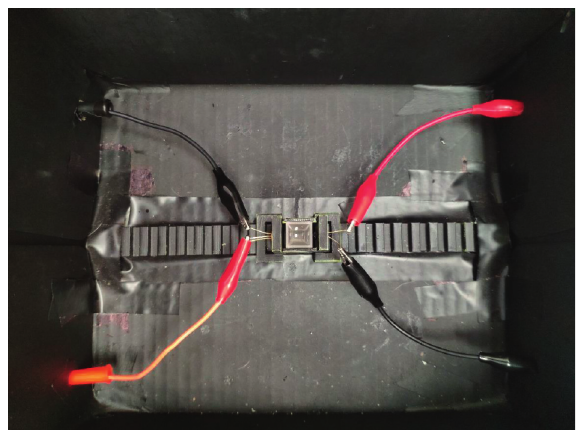
Figure 1: Prototype used for glucose measurement.